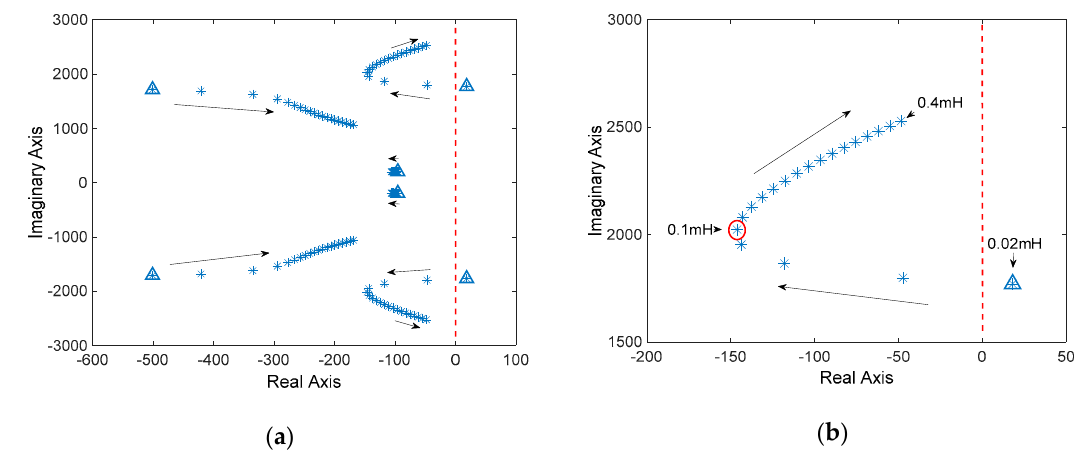
Figure 8. ( a ) Root-locus diagram of the studied dc microgrid system with virtual negative inductor varying from 0.02 mH to 0.4 mH; ( b ) Zoom.